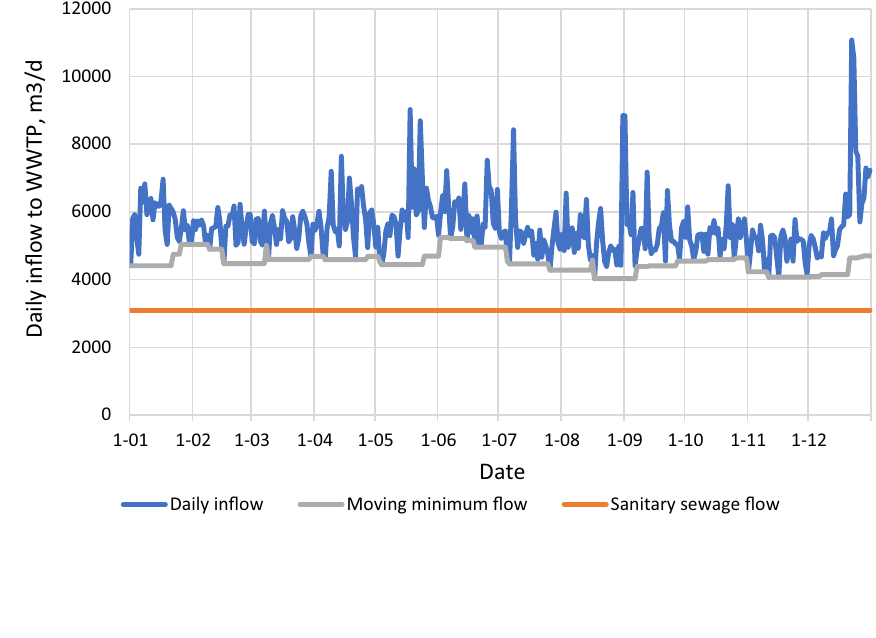
Fig. 9 Moving minimum flow plotted on a daily inflow dia- gram in the year